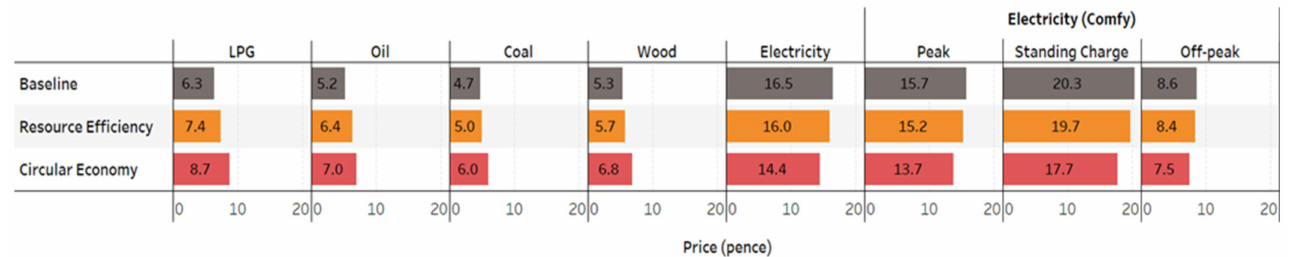
Figure A1. Fuel prices for baseline and future scenarios [55–58].